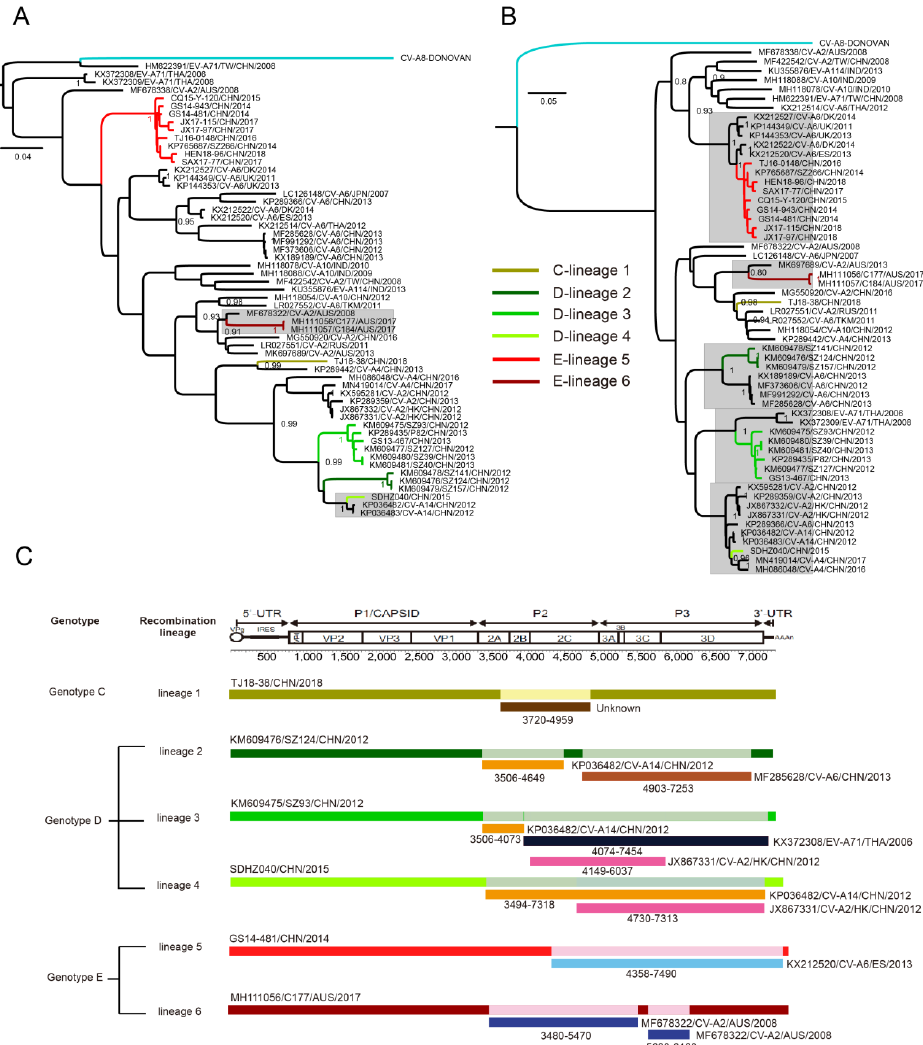
Figure 4. Maximum likelihood phylogenetic trees of 23 CV-A8 variants combined with 35 other EV-A strains screened from GenBank constructed based on the ( A ) P2 non-capsid region and ( B ) P3 non-capsid region. The CV-A8 recombinants and some of the other serotype strains which clustered closely together and formed a clade with a high bootstrapped value were shaded with grey background, the prototype strain was marked in blue. ( C ) Specific recombination event detection using the RDP4 software